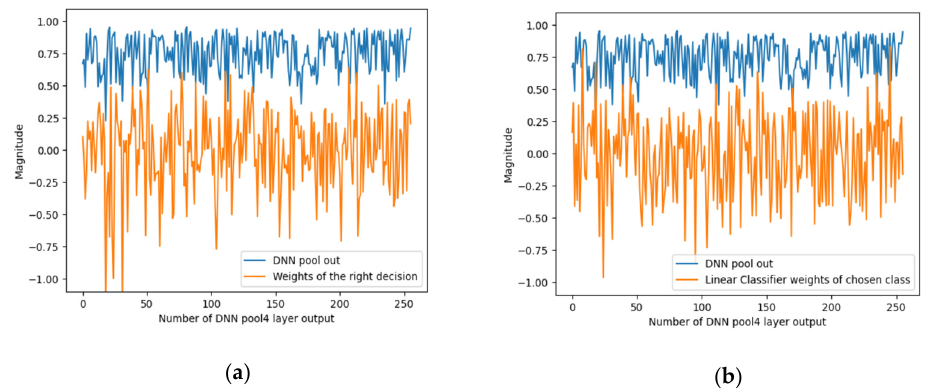
Figure 5. An example of the output signals of the DNN pool out from the 4th layer, representing the basic features in the DNN and linear classifier: ( a ) the corresponding signal/weights class that should have been correct, and ( b ) the most highly correlated signal/weights that were incorrectly selected as the correct class.